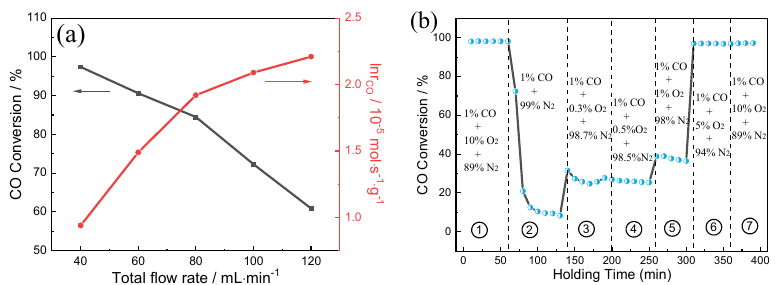
Figure 8. ( a ) Catalytic activity of (0.5TiO 2 − Pt)/CeO 2 under different space velocities at 70 °C. The measurement was performed using 100 mg of the catalyst with a mixed gas of 1% CO, 10% O 2 , and rest N 2 at a flow rate ranging from 40 to 120 mL min − 1 . ( b ) Catalytic performance under varied oxygen concentrations.